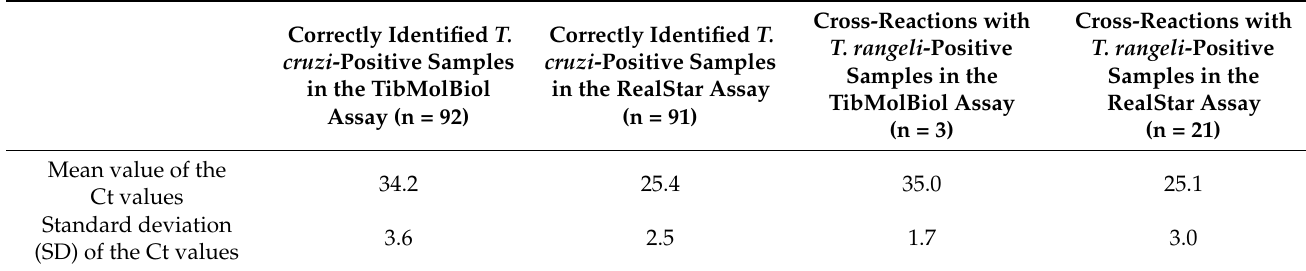
Table 4. Cycle threshold (Ct) values (mean, standard deviation (SD)) for correctly identified sam- ples and for cross-reactions with T. rangeli -positive samples in the TibMolBiol assay and in the RealStar